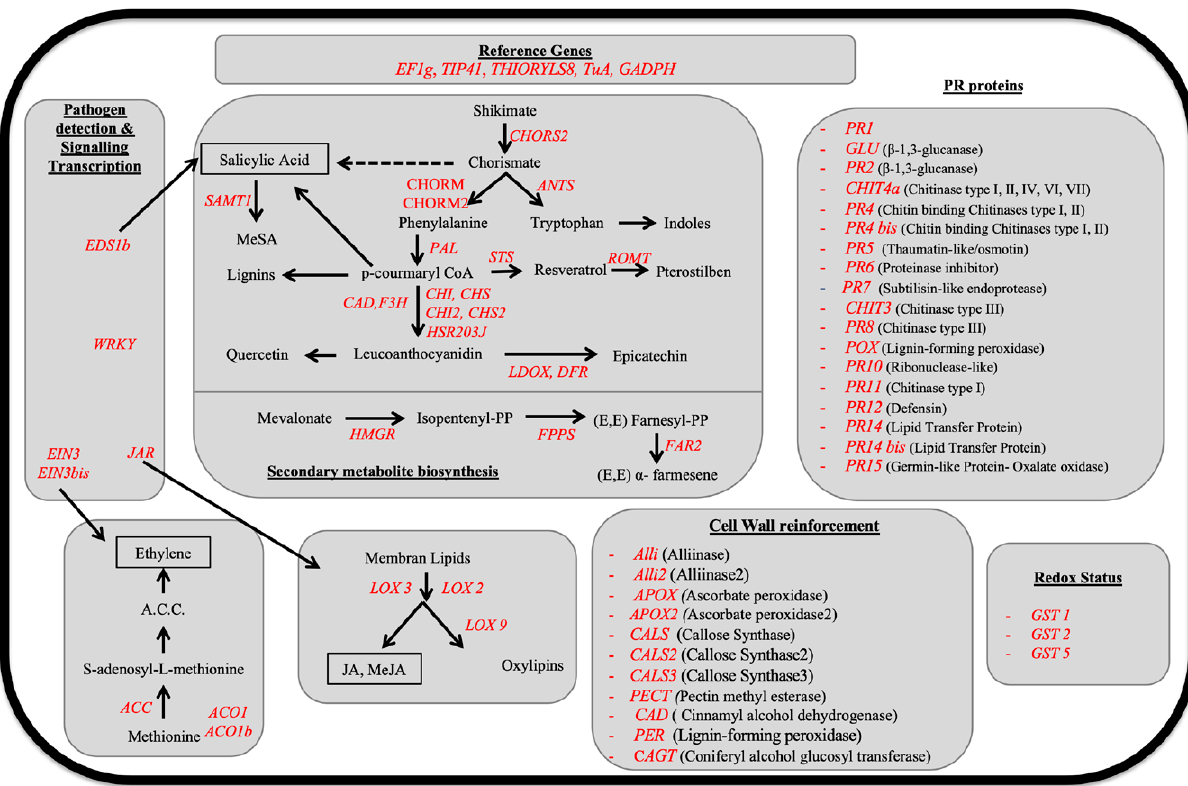
Figure 1. Sixty-two selected genes of “the NeoVigen96” chip are involved in different pathways of the grapevine defence system (Dufour et al., 2016). Housekeeping (five genes), PR proteins (18), secondary metabolite biosynthesis (13), cell wall reinforcement (11), indole pathway (five), redox status regulation (three), oxylipin pathway (three) and hormone signalling pathway (nine